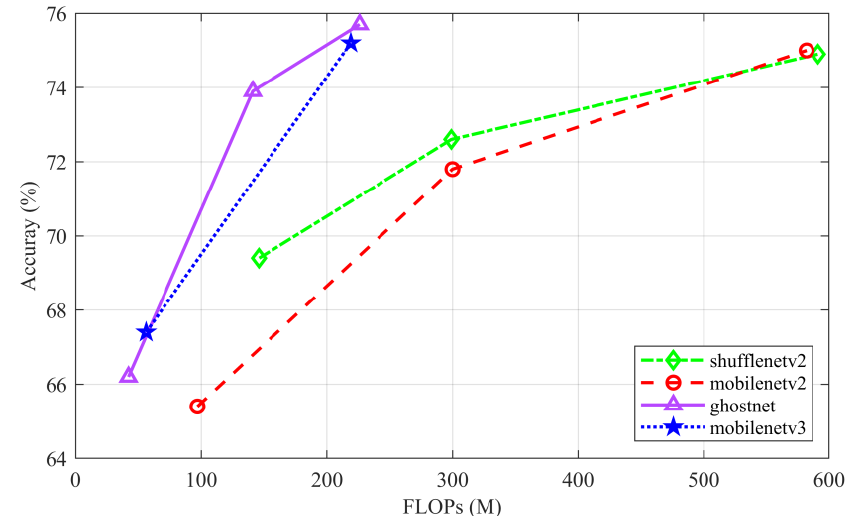
Figure 3. Performance comparison of compact models.